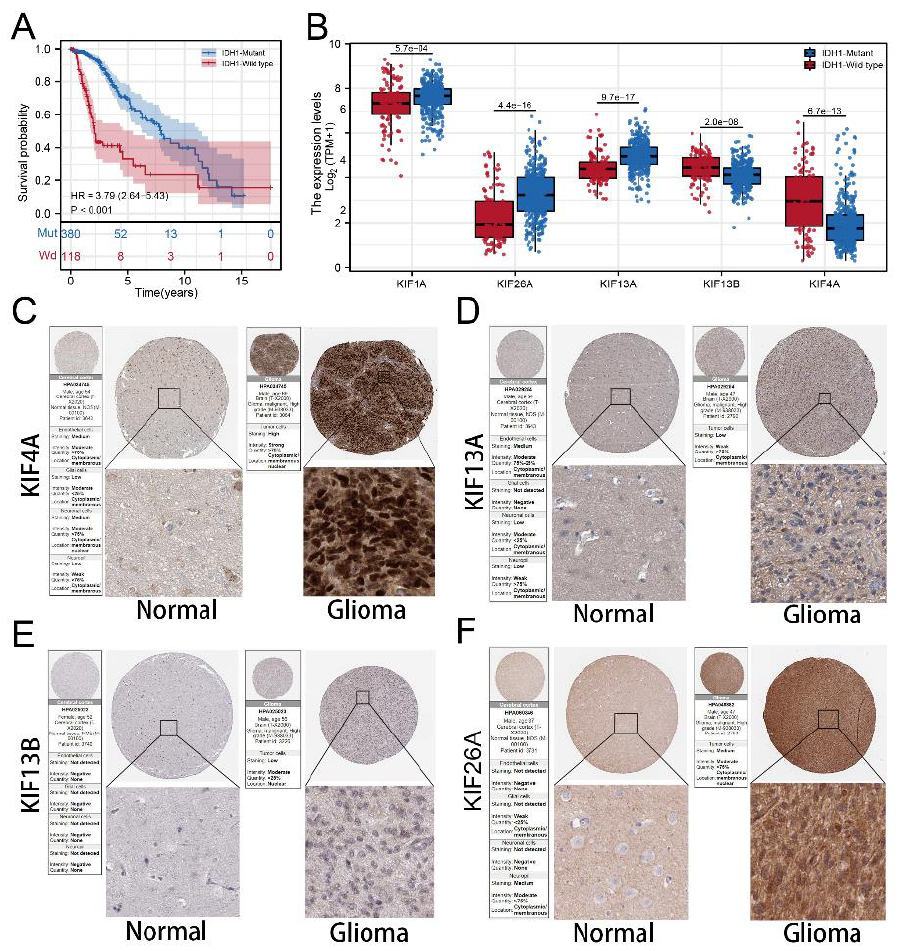
Figure 8. Protein expression of signature KIFs in HPA database. Notes: ( A ) Kaplan–Meier survival curves analysis comparing overall survival between patients in the IDH1-mutant group and IDH1- wild group; ( B ) differential expression analysis of signature KIFs between patients in IDH1-mutant group and IDH1-wild group; ( C – F ) immunohistochemistry images of 4 signature KIFs from TCGA glioma cancer patients and GTEx normal brain tissue.